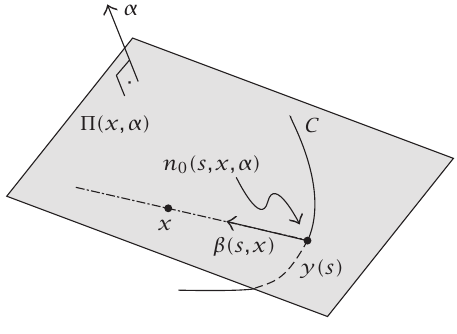
Figure 2.1 . Illustration of weight function n